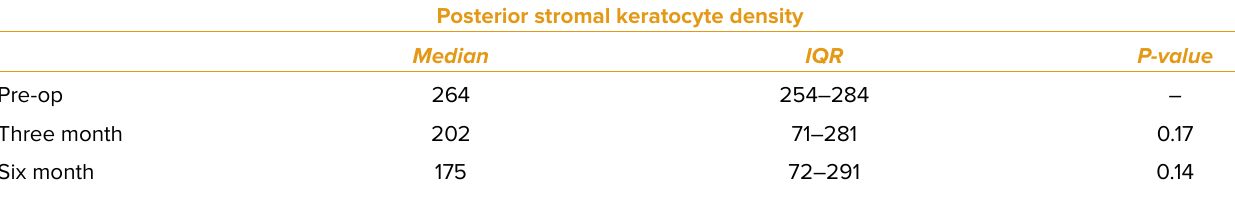
Table 2. Quantitative analysis of posterior stromal keratocyte density before and after Hypotonic collagen